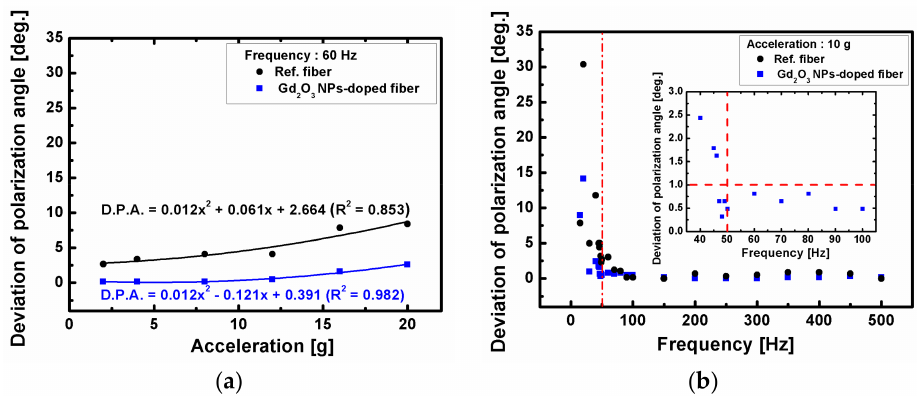
Figure 8. Vibration dependence of the Gd 2 O 3 NPs-doped fiber and the reference fiber as a function of ( a ) acceleration under the frequency of 60 Hz and ( b ) frequency under the acceleration of 10 g. The inset in ( b ) shows the enlarged DPA of the Gd 2 O 3 NPs-doped fiber from 45 Hz to 50 Hz with the interval of 1